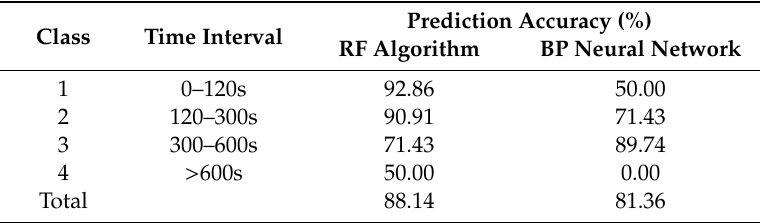
Table 7. Comparison of the prediction performance of the Random Forest and Back-Propagation (BP) neural network.